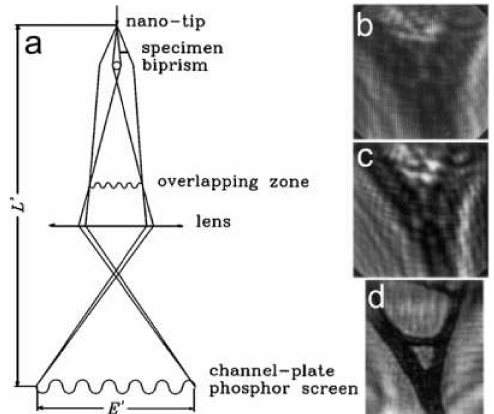
Figure 14. Low-energy electron o ff -axis holography. ( a ) Schematic arrangement of the low-energy holographic electron microscope with a biprism. ( b – d ) Imaging of a perforated carbon foil: ( b ) o ff -axis hologram, ( c ) in-line hologram without biprism, and ( d ) amplitude reconstructed from ( b ). The field of view is 217 nm. Figure reprinted from [56], copyright (1996) by the American Physical